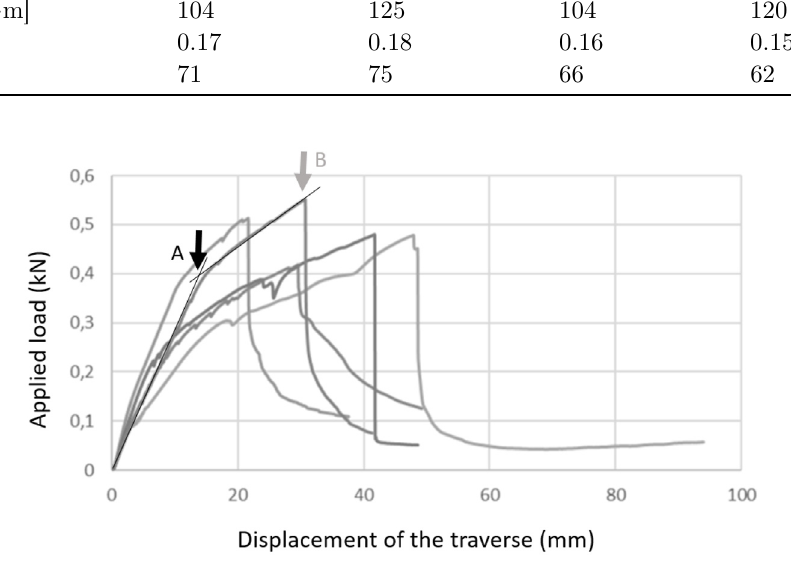
Fig. 9. Two-screws assembly: evolution of the applied load as a function of the displacement. Table 5. Two-screws assembly: summary table of limit and maximum load